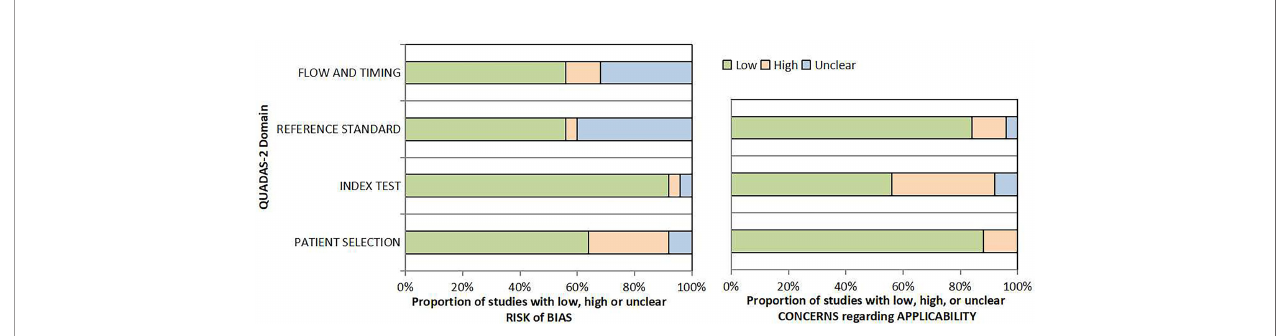
FIGURE 2 | Quality assessment according to QUADAS-2 of the included